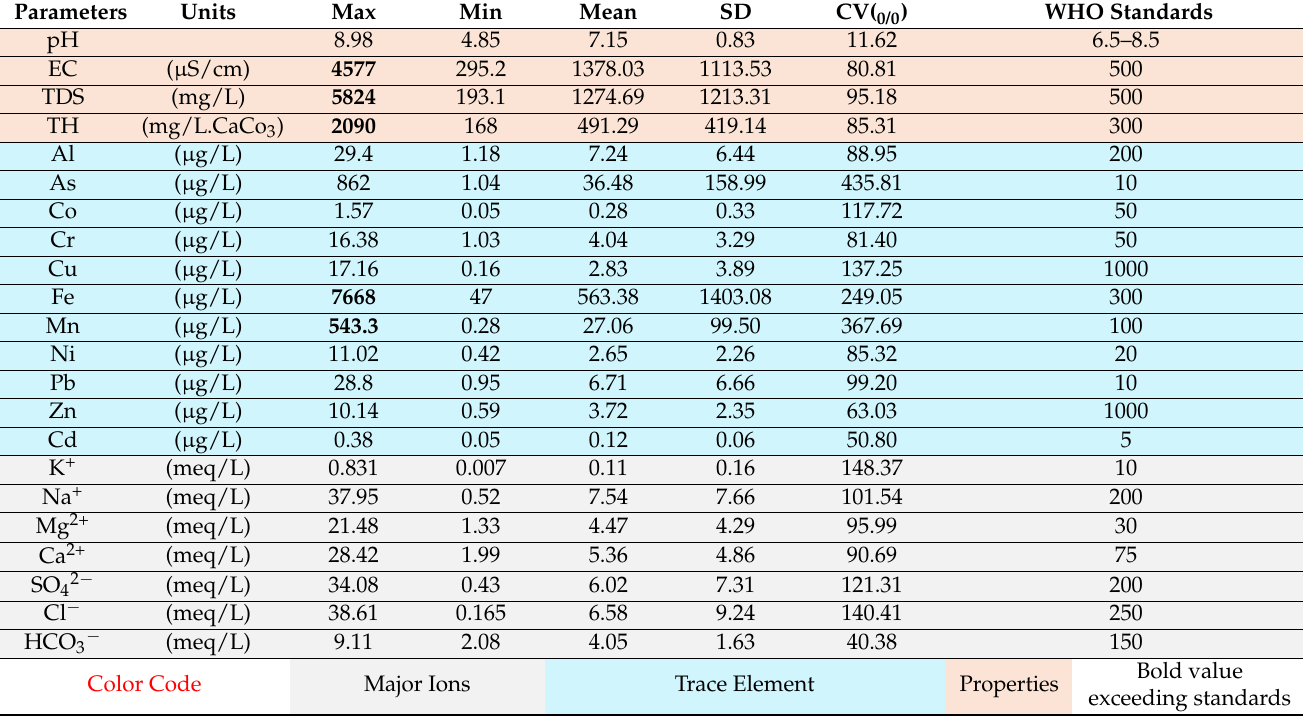
Table 2. Statistics of the water quality data used in this study.